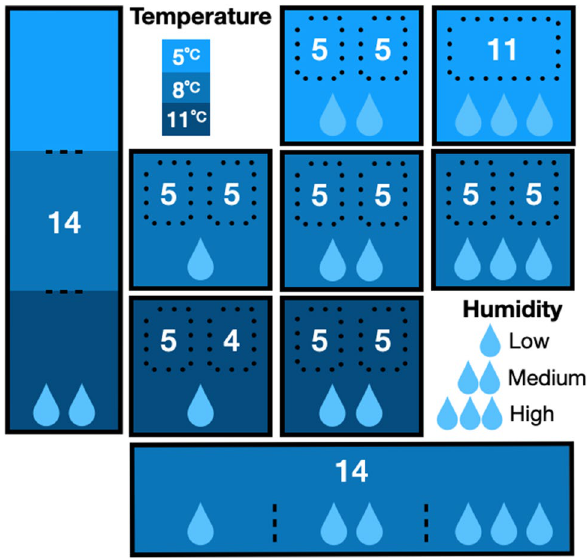
Figure 1. Schematic of the experimental design and sample sizes with 7 environmental chambers with fixed temperature and humidity conditions and two sets of connected chambers allowing bats to behaviorally select temperature (left) or humidity conditions (bottom) for the infection trial on tri-colored bats ( Perimyotis subflavus ). Water loss conditions were based on water vapor pressure deficit (VPD) levels set to 0.05 kPA to produce low potential evaporative water loss (pEWL) for high humidity, 0.10 kPa for medium pEWL and humidity, or 0.15 kPA for high pEWL and low humidity. Numbers are sample sizes of bats assigned to separate cages within each chamber. Bats in the low temperature and high humidity chamber were combined into a single cage after a camera failed at the start of the experiment (top